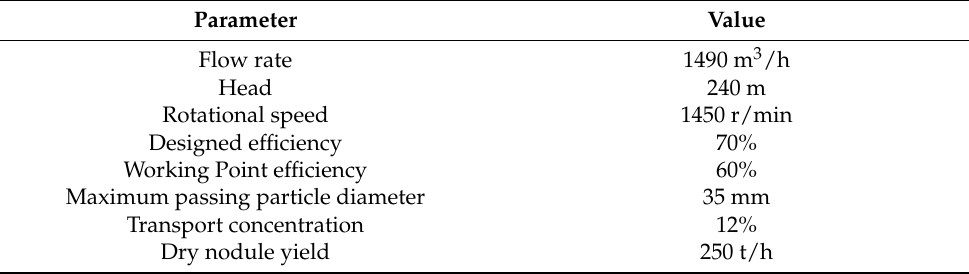
Table 2. Basic technical parameters of commercial production